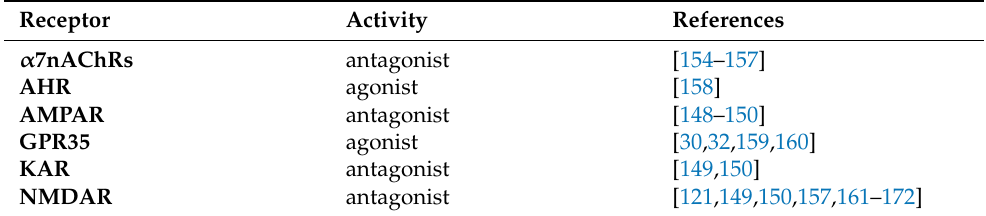
Table 2. Receptor-binding profile of